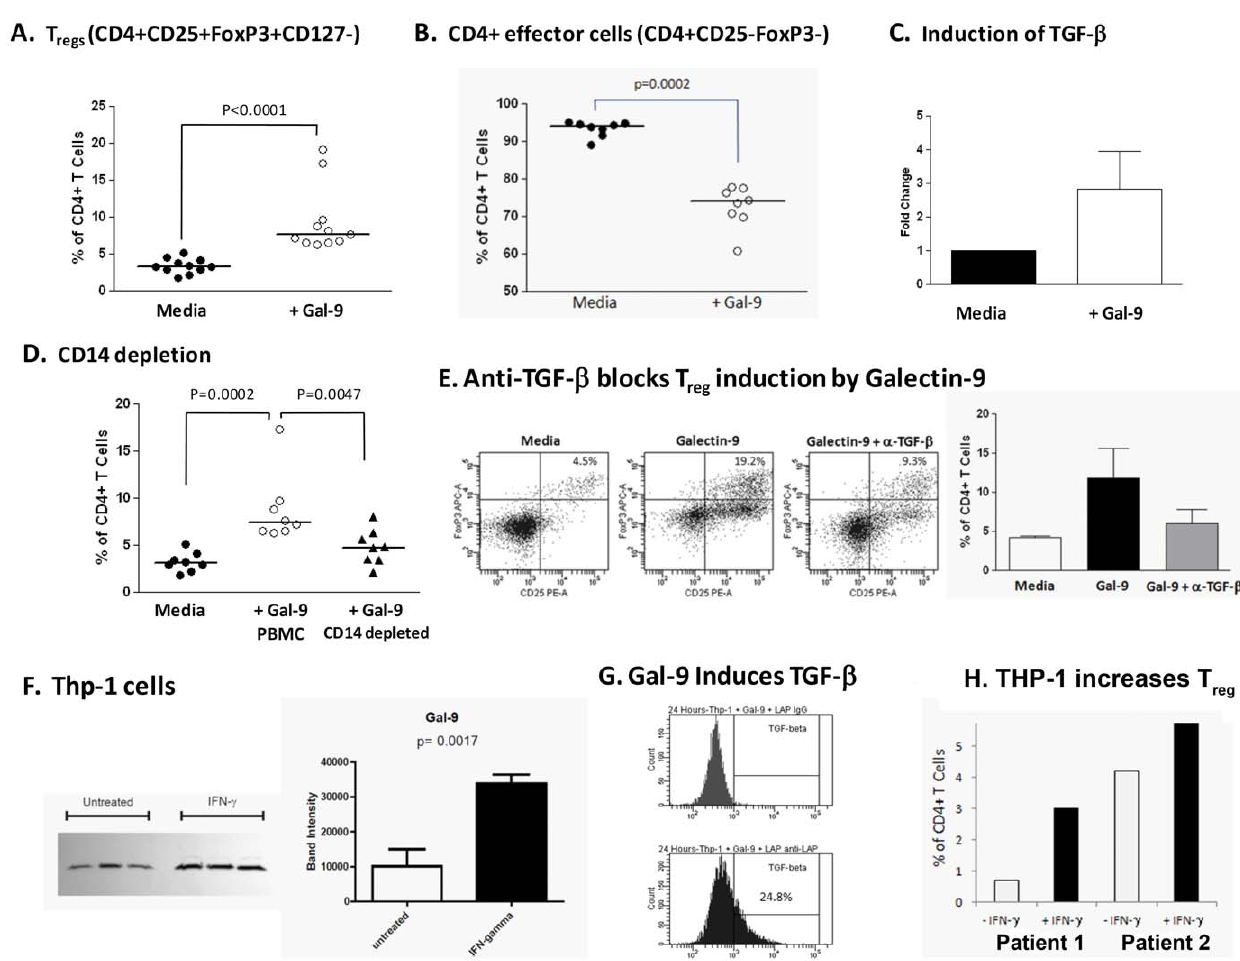
Figure 5. Galectin-9 induces regulatory T cells (T regs ) via TGF- b . Peripheral mononuclear cells (2 6 10 6 /ml) isolated from 5 chronic HCV patients and 6 normal controls were cultured for 5 days in media alone (RPMI + 10% human serum) 6 galectin-9 (5 ug/ml). After the culture period Treg levels were estimated using flow cytometry. Tregs were defined as CD4 + CD25 + FoxP3 + CD127 2 T cells. Culture in the presence of galectin-9 induced Tregs ( A ) and a concomitant reduction in the CD4 + CD25 2 FoxP3 2 effector population was observed ( B ). ( C ) CD14 + monocytes were isolated from 3 chronic HCV patients and cultured in for 48 hours in media alone (RPMI + 10% human serum) 6 Galectin-9 (5 ug/ml). Galectin-9 increased the relative expression of TGF- b 1 mRNA as analyzed by real time PCR. ( D ) Depletion of CD14 + cells from PBMC (8 normal patients) cultures treated with Galectin-9 attenuated the induction of Tregs at 5 days. ( E ) The addition of anti-TGF- b antibody at day 0 and day 2 of culture with PBMC and galectin-9 blocked induction of the Treg population. Representative flow plots are shown; the bar graphs are derived from three separate experiments. ( F )